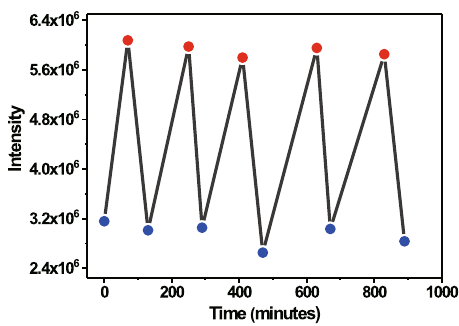
Fig. 7 The durability of degassed PZDN ( ) ⇆ PZDQC ( ). The experiment proceeded in cyclohexane, and the emission intensity at ~495 nm